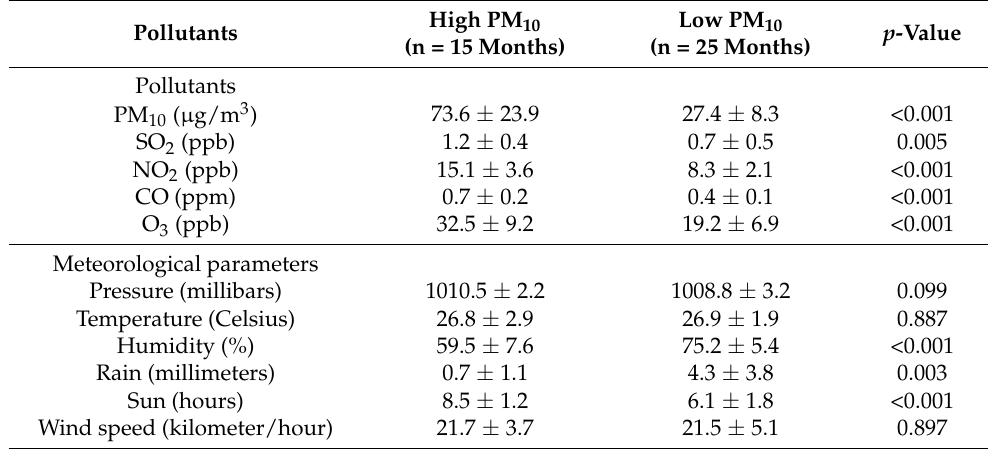
Table 2. Pollutant Data between High PM 10 Period ( ≥ 45 µ g/m 3 ) and Low PM 10 Periods (<45 µ g/m 3 ) Recommended by WHO Air Quality Guidelines 2021.